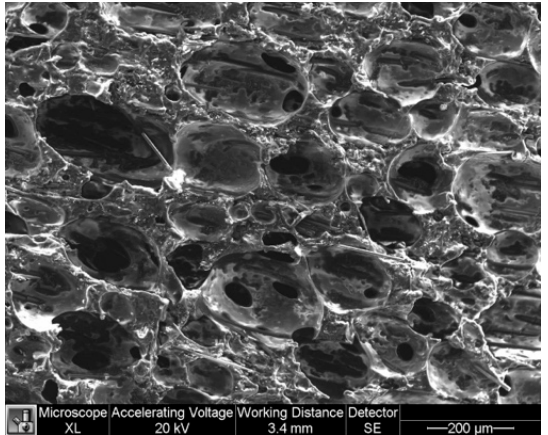
Figure 1. SEM image of closed cell NCPF structure, containing conductive particle additives.